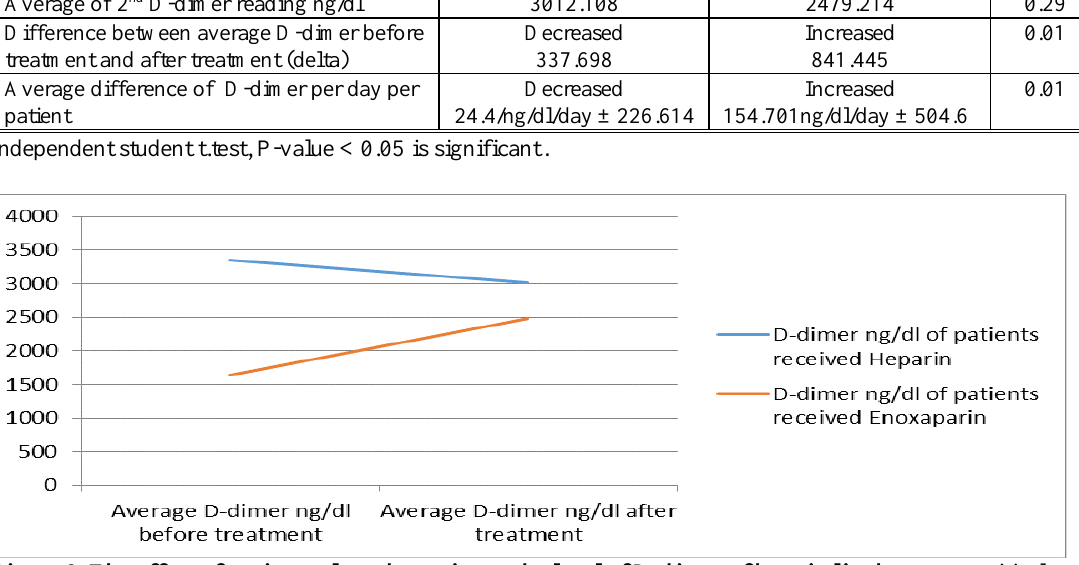
Figure 2. The effect of anticoagulant therapies on the level of D-dimer of hospitalized, severe –critical COVID-19 infected patients.